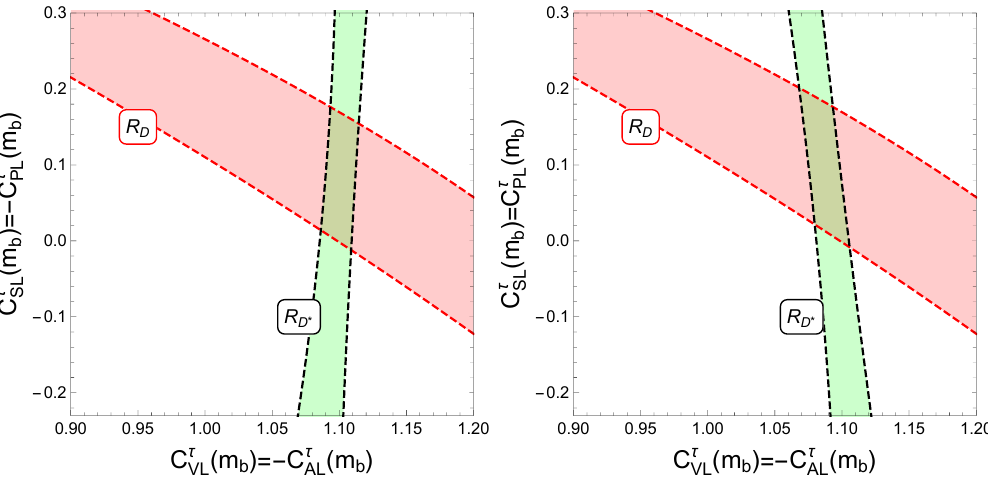
(= (cid:0) C (cid:28) ) and VL AL